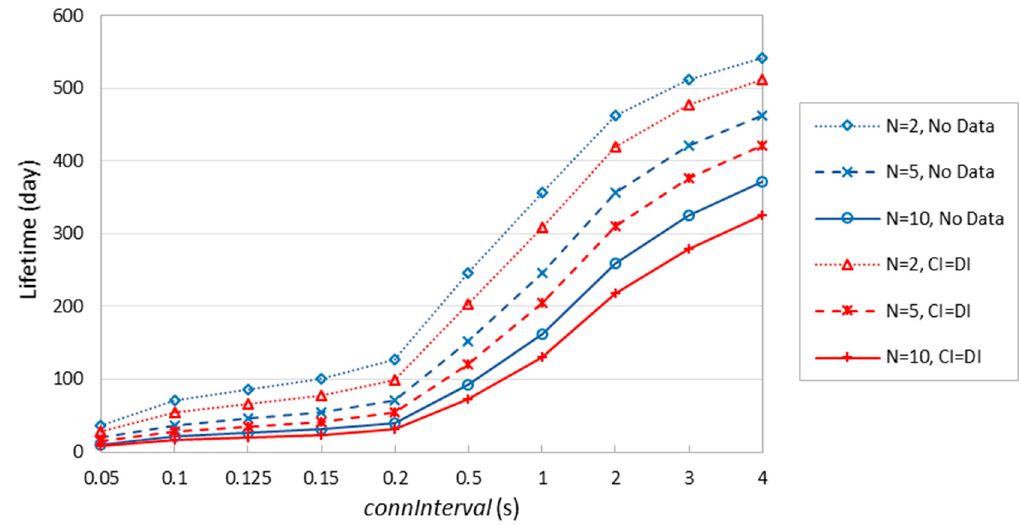
= 2, N = 5, and N = 10 connected